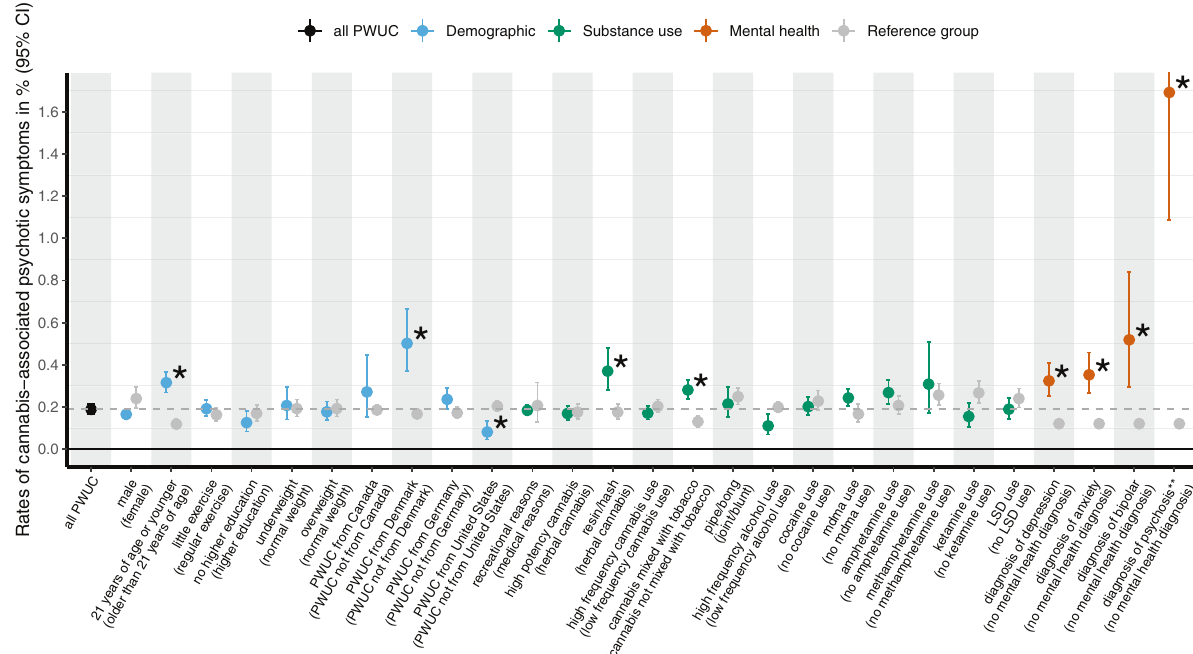
Fig. 2 Rates of cannabis-associated psychotic symptoms (CAPS) in subgroups of people who use cannabis (PWUC). Rates are estimated for cannabis-associated psychotic symptoms (CAPS, involving hallucinations and/or paranoia) requiring emergency treatment in subgroups of people who use cannabis (PWUC). The sample was restricted to individuals with data on last year CAPS ( n = 148,109). The dashed line (gray) indicates the overall rate of last year CAPS (i.e., 0.19%, also displayed in Fig. 1). Of all subgroup comparisons ( k = 53), displayed here are only those conducted in subgroups including at least 15 individuals with documented last year CAPS. The complete table of all subgroup comparisons, as well as the corresponding Risk Ratios, is included in Supplementary Table S6. Detailed information regarding the coding of the grouping variables is provided in the sMethods (Supplement). The asterisk (*) highlights those comparisons that were signi fi cantly different ( p < 0.05) in univariate analyses after False Discovery Rate (FDR) correction to adjust for multiple testing ( k = 53 comparisons). **Subgroup of PWUC who reported to have been diagnosed with psychosis excludes those individuals with CAPS that did not return to normal within 4 weeks following the